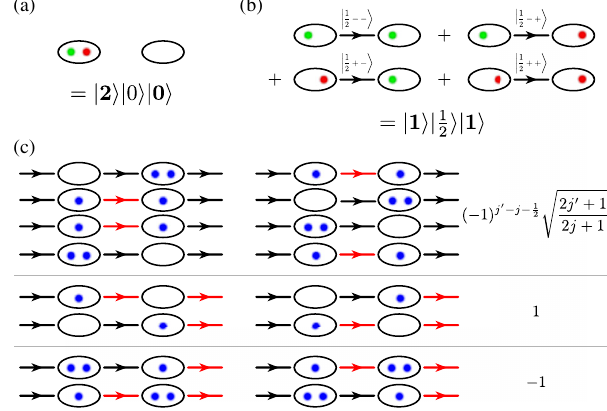
FIG. 1. (a) Strong coupling configuration with an odd site filled with two fermions, one of every color, and its neighboring empty even site. (b) Resulting color-neutral superposition of four states after applying the operator V . Each of the four states has a single fermion per site and a color-electric flux of j ¼ 1 = 2 on the intermediate link, with a different combination of z components. The corresponding state in the color-neutral basis for those two cases is written below. (c) Transitions induced by the operator V in the color-neutral basis. The left block represents the possible gauge-invariant starting configurations j ϕ , the right block the i i final states j ϕ after application of the operator V . The arrows f i show the gauge links, where the black arrows indicate a color- electric flux of j and the red arrows a value of j 0 ¼ j (cid:3) 1 = 2 . The sites are represented by ovals, where the small blue dots indicate the number of fermions sitting on the site. The numbers to the V j ϕ right show the matrix element h ϕ f j i i